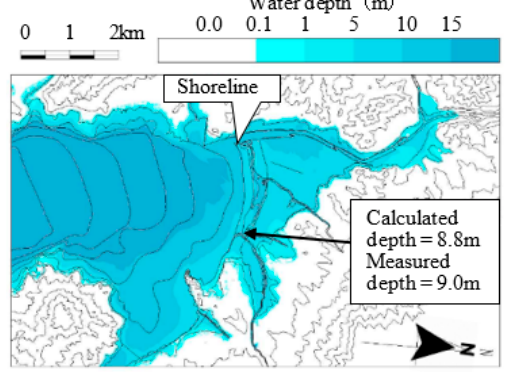
Figure 33. Flood situation in Rikuzentakata Coast 31 min after arrival of the 2011 huge tsunami.